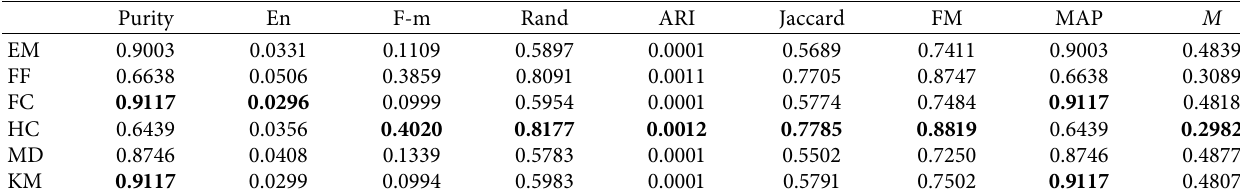
Table 3: Initial values of the nine external measures for the Ionosphere data set.